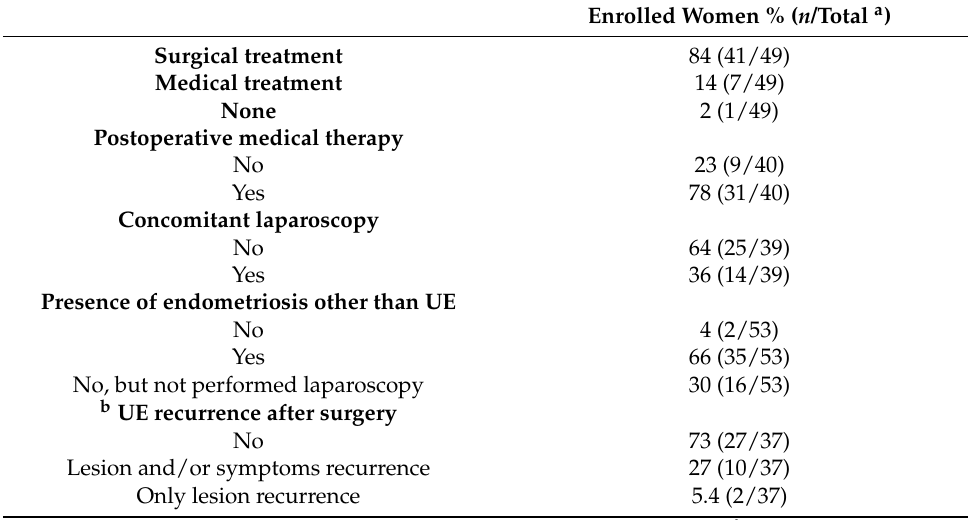
Table 2. Treatment modality and clinical characteristics of